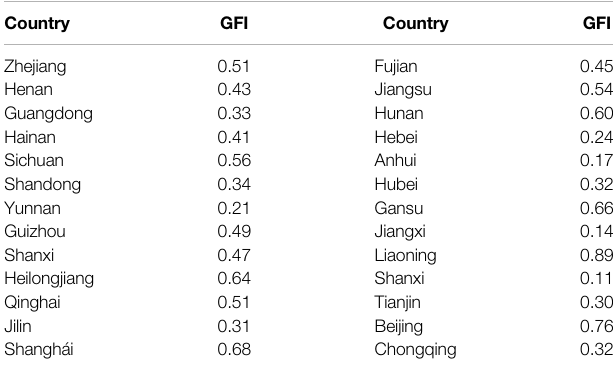
TABLE 2 | Green Finance